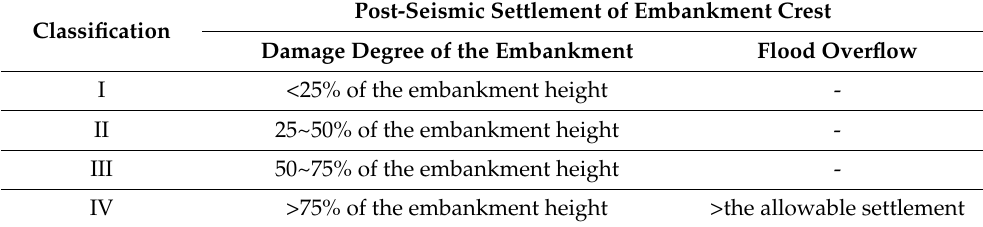
Table 1. Seismic safety classification of an